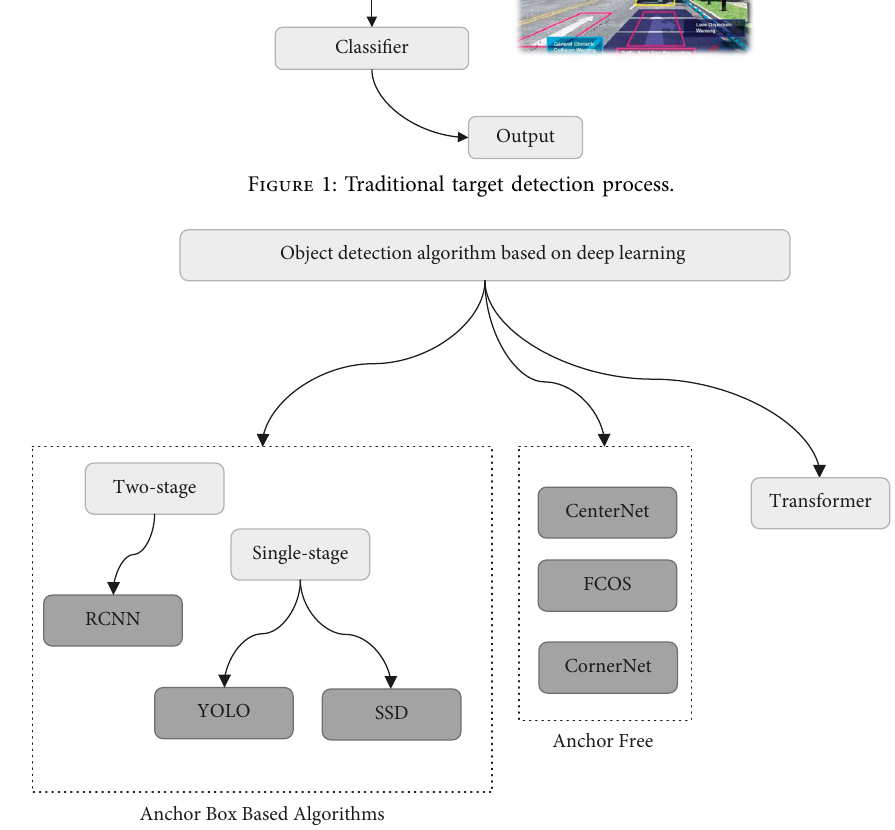
Figure 2: Research progress of STD based on DLA.